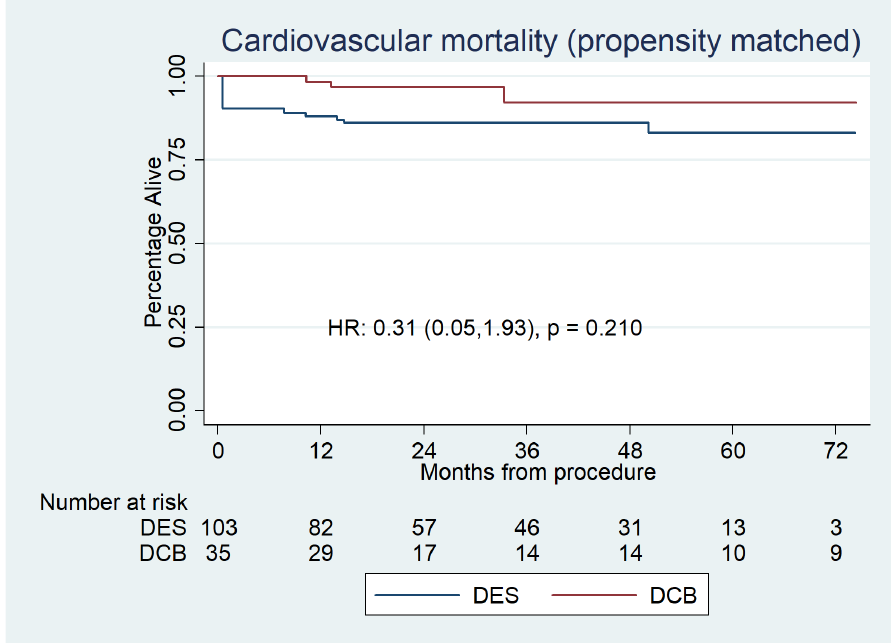
Figure 5. Propensity-matched Kaplan–Meier survival plot for cardiovascular mortality for DCBs versus DESs, which shows no significant difference between the groups. Target vessel myocardial infarction occurred in 0 (0%) DCBs and 7 (6.5%) DES as shown in Figure 6.